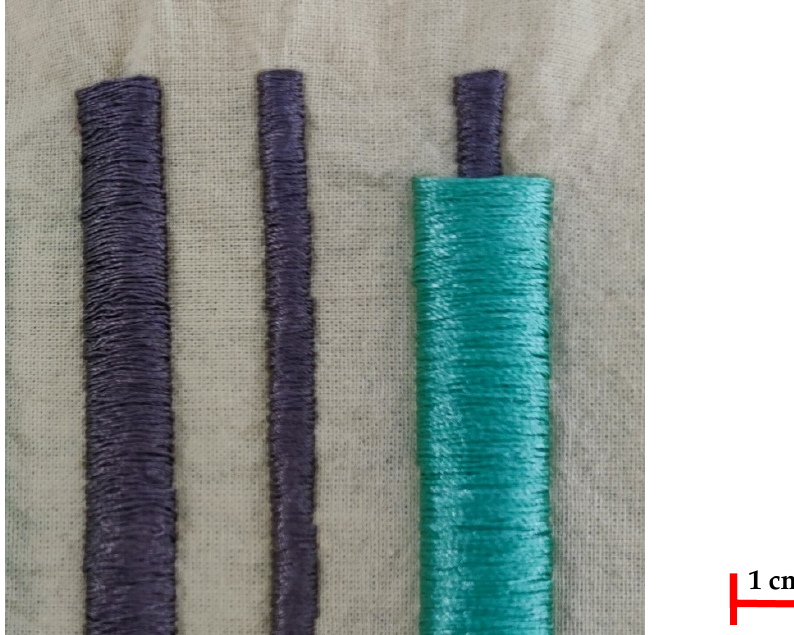
Figure 1. The embroidered conductive-thread patches in the two variations, with the control pattern on the left-hand side.